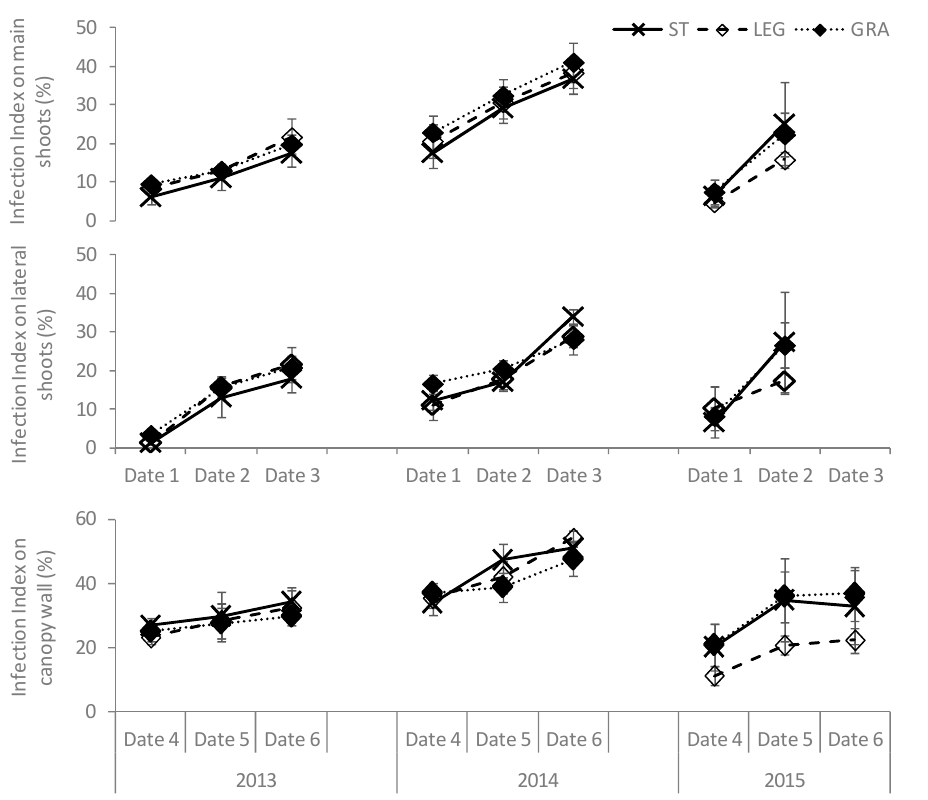
Figure 2. Development of the downy mildew infection index detected on the main shoot leaves, on lateral shoots, and on the canopy wall, in the three soil management treatments. Values are the mean ± standard error.